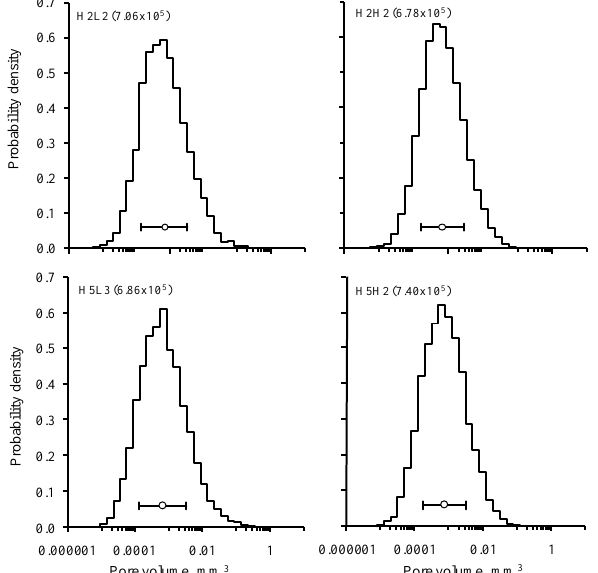
Figure 4. Probability density distributions versus coordination number for Hamra 2.0 and 0.5mm aggregate treatments (H2 and H5) and low- and high-compaction treatments (L and H). Selected replicates are shown in the figure (last number in treatment name is replicate). Coordination number (CN) is the number of curve seg- ments meeting at the vertex and Co is the characteristic coordination number constant, which is the value in each